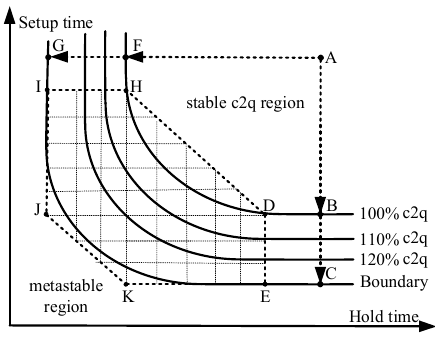
Figure 6. Simulation range of the setup and hold time pair.